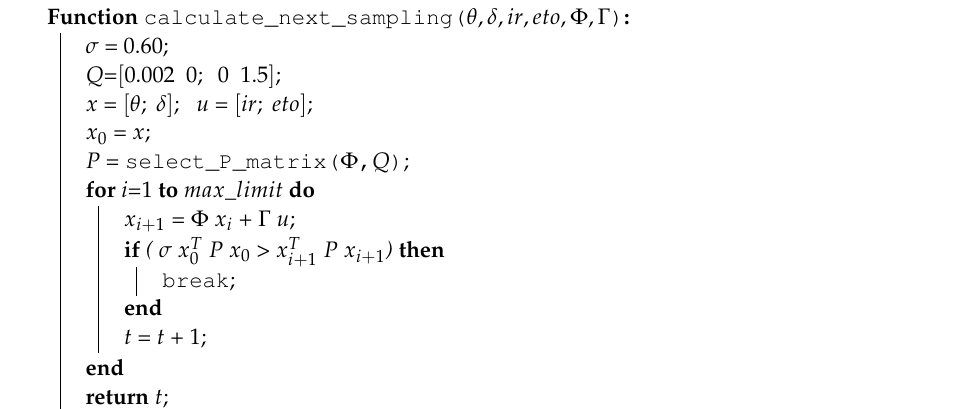
Algorithm 3: The next sampling estimation based on Lyapunov